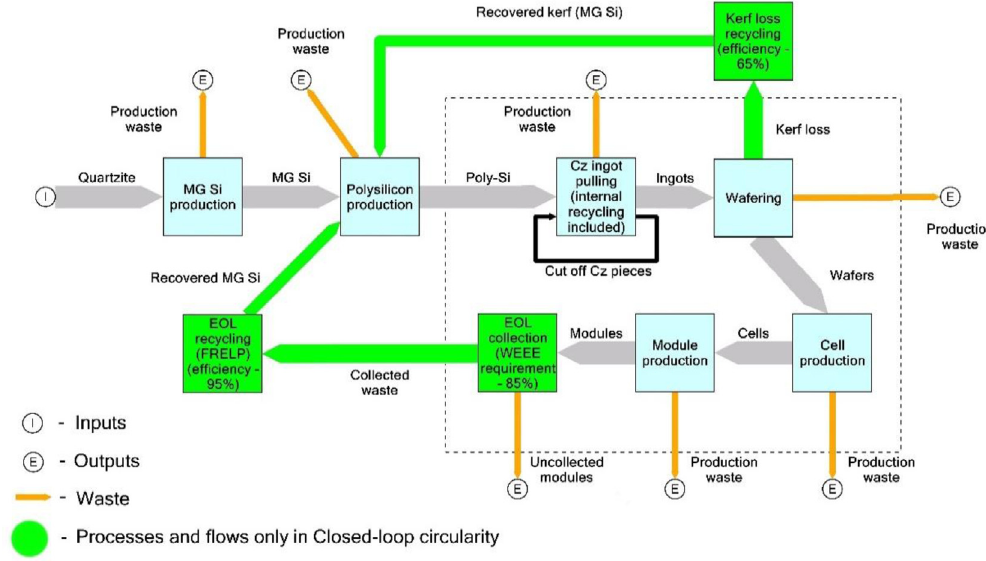
Fig. 2. Supply chain for poly-Si applied in the